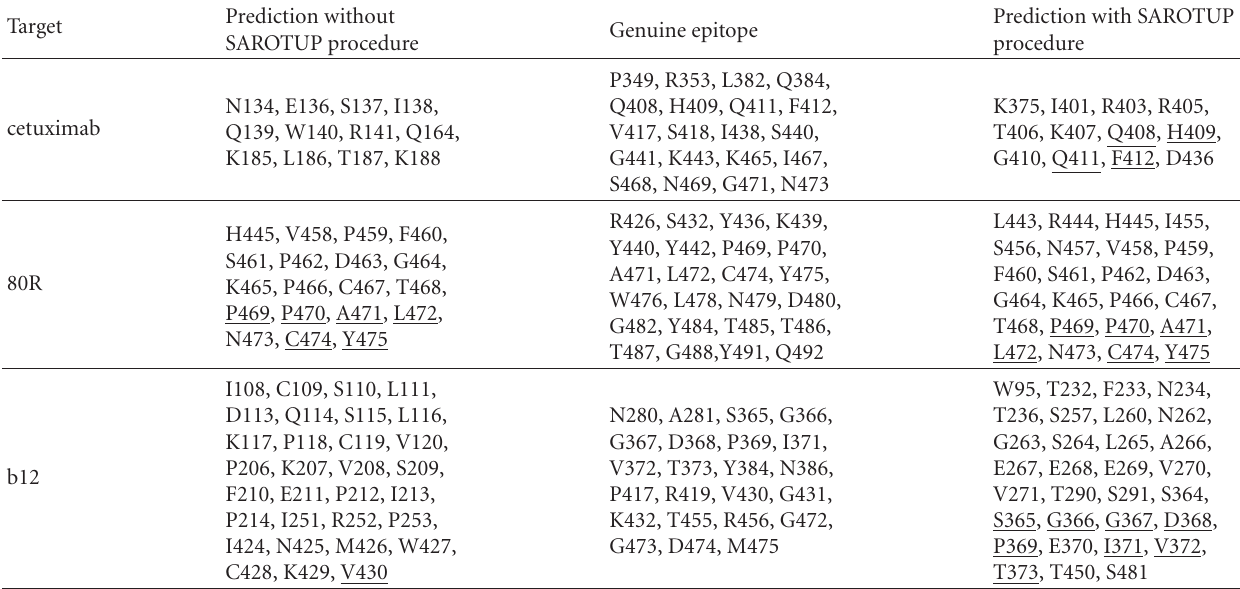
Table 4: Mimotope-based epitope prediction with or without SAROTUP